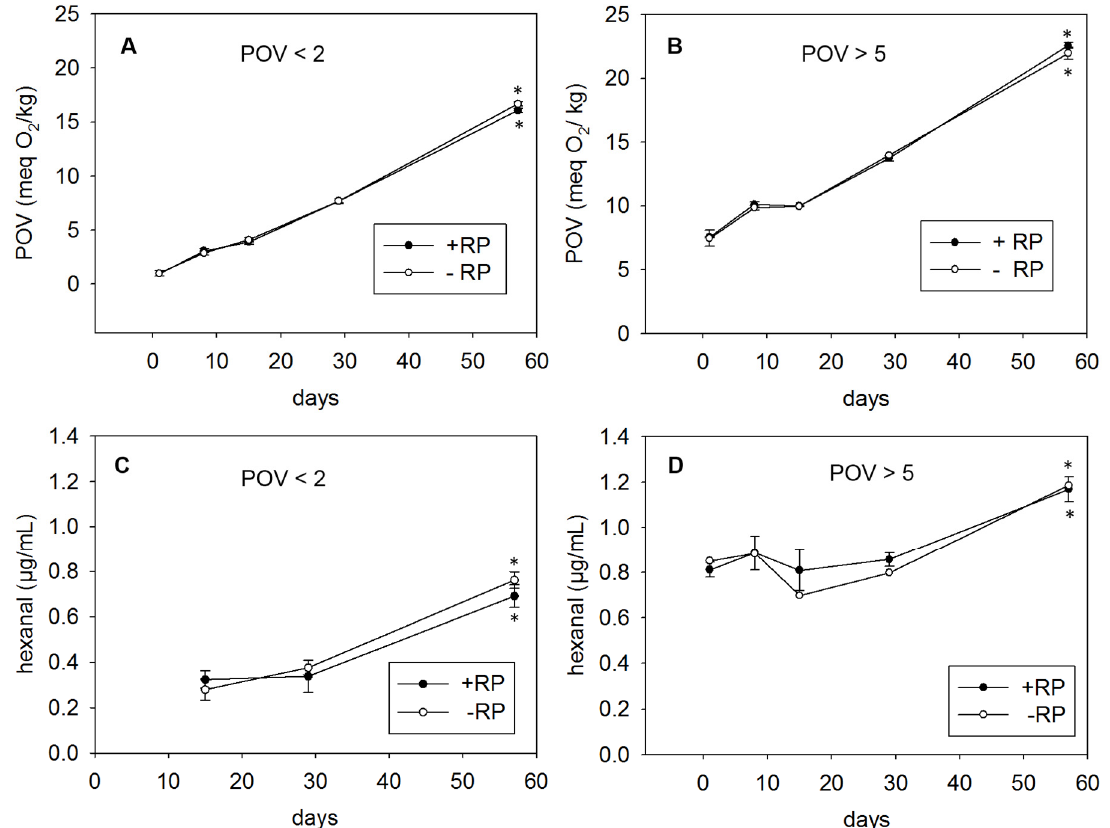
Figure 2. POV of mildly ( A ) and highly ( B ) oxidized palm oil and hexanal formation in mildly ( C ) and highly ( D ) oxidized palm oil in the presence or absence of RP after household-representative storage for up to 57 days. Data are expressed as mean ± standard deviation (SD) ( n = 4). Asterisks (*) indicate a statistically significant difference vs. day 1 ( p < 0.05).